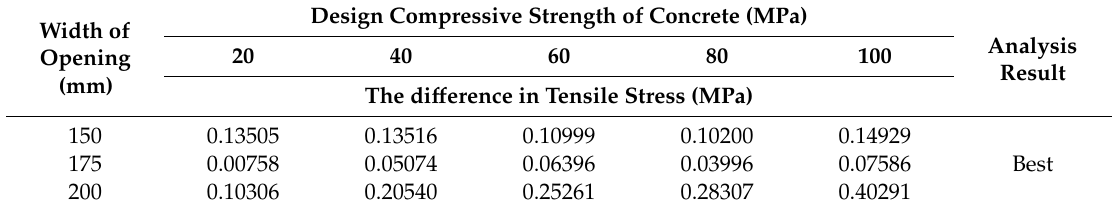
Figure 6. Tensile stress difference of concrete tie member in ABAQUS. Table 2. The difference in tensile stress at the tie member obtained from ABAQUS analysis for different widths of opening.